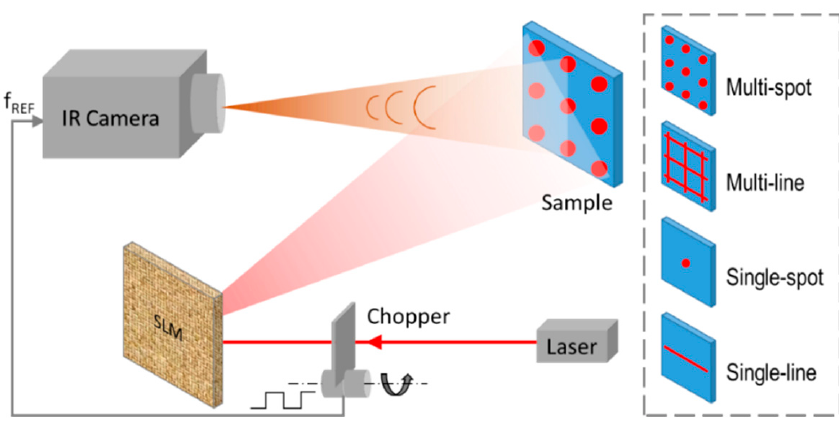
Figure 2. The schematic of a reconfigurable laser lock-in thermography system. This detection scheme is used to characterize microcracks in two types of metallic sam- ples. Sample A is a porous nickel superalloy metal plate. It has many surface features and requires a large area inspection. For this sample, a multi-spot illumination configuration is applied to compare with the single-spot configuration. In the single-spot configuration, low modulation frequency/long data acquisition time are required to cover a large inspection area. With the multi-spot configuration, total inspection time can be saved. Sample B is a set of Ti-6Al-4V (Ti64) alloy metal blocks with thermal fatigue surface cracks (TrueFlaw, Espoo, Finland). Provided with the crack specifications, the single-spot LLT is used to analyze the crack sizing in detail and the data are fitted by an empirical formular. From the fitting, an empirical parameter is proposed for the calibration of the crack